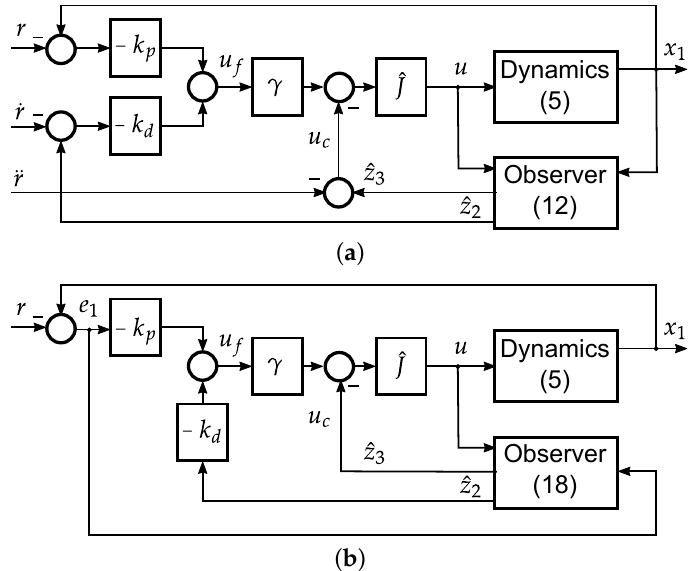
Figure 2. Block diagrams of the control structures (in the parenthesis essential mathematical formulas are recalled): ( a ) ADRC, ( b )